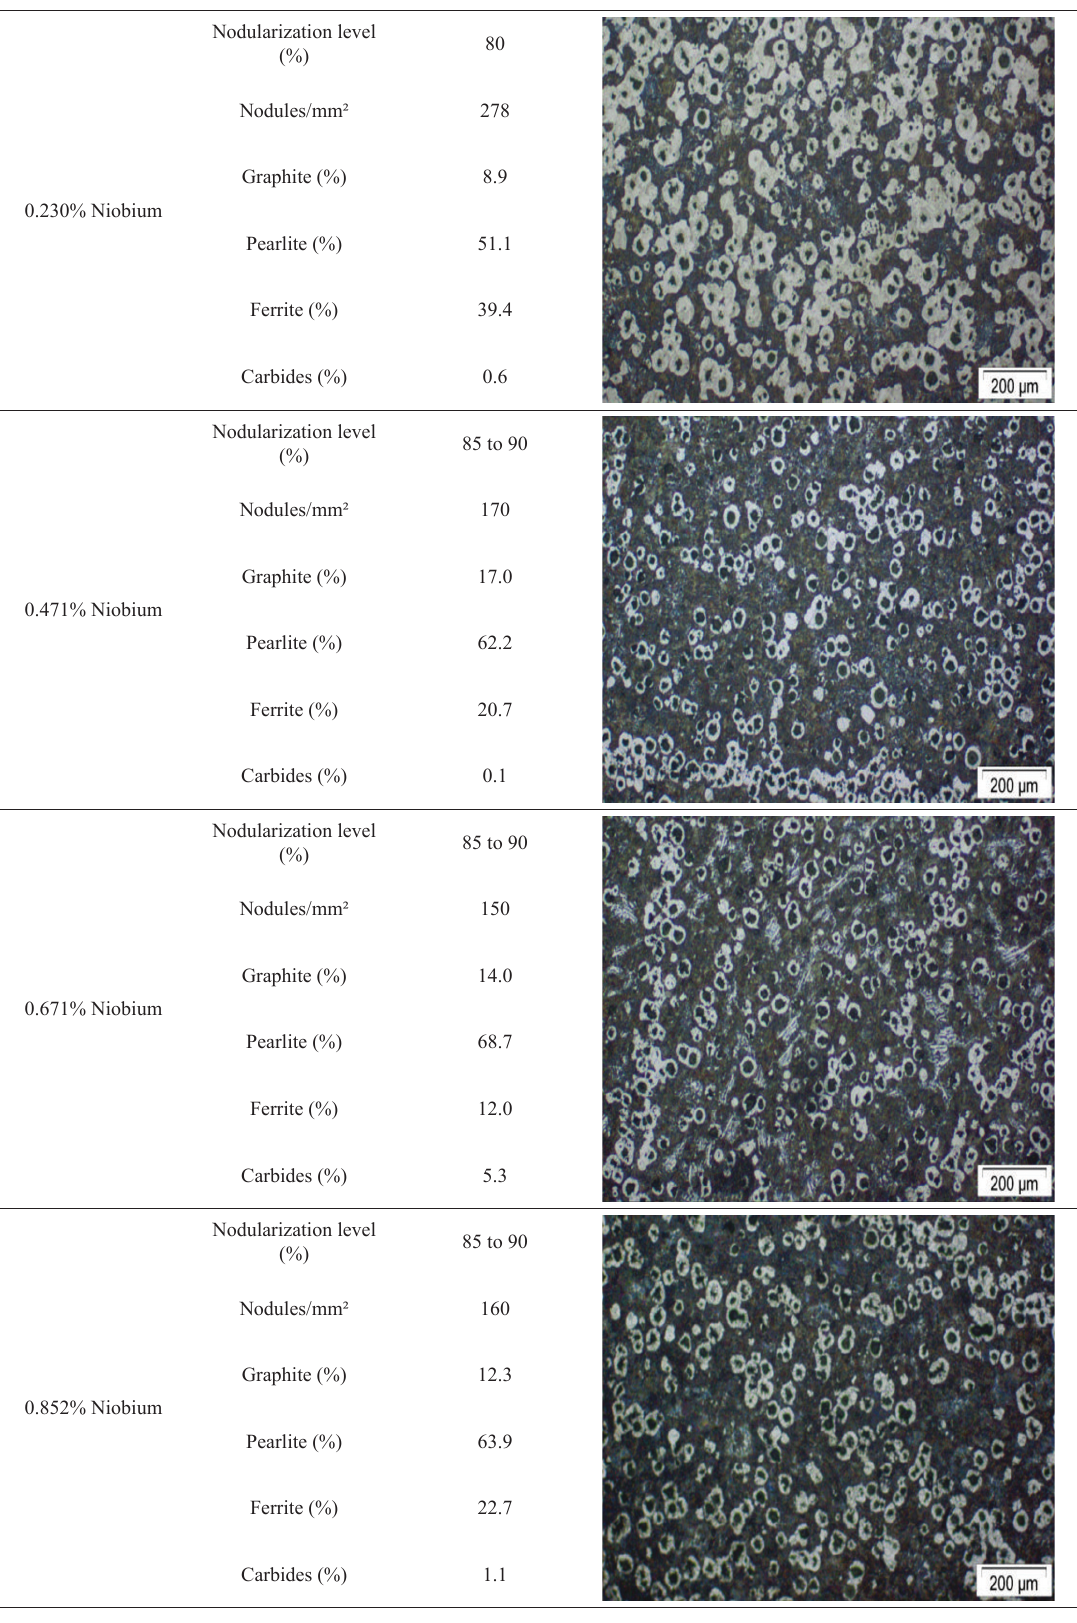
Table 2. Characterization of NCIs with Niobium (optical